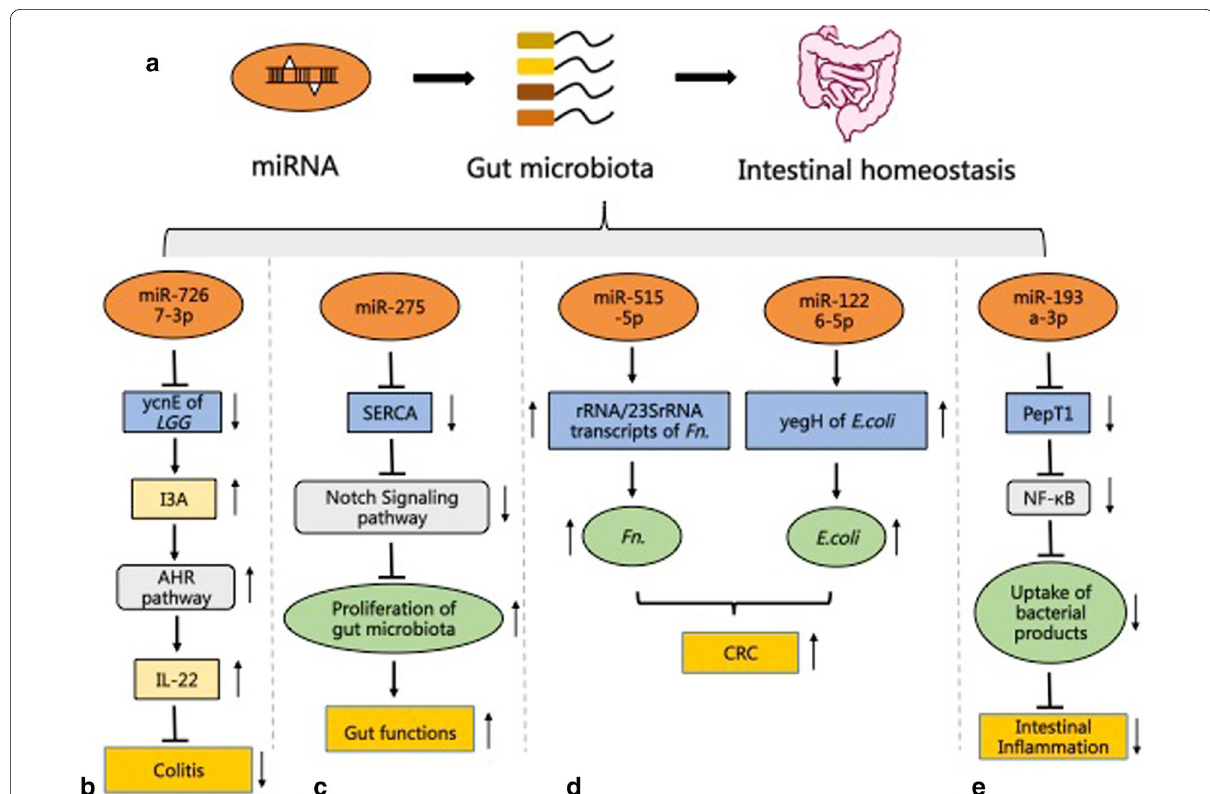
Fig. 1 MiRNAs regulate the gut microbiota affecting intestinal homeostasis. a MiRNAs regulate the gut microbiota influencing the intestinal homeostasis of the host. b The mechanism of miR7267‑3p alleviating colitis by repressing ycnE expression of the gut microbiota. c MiR‑275 protects gut functions in mosquitoes by shaping the gut microbiota. d MiRNAs promote the growth of the gut microbiota through the promotion of transcription, affecting the host CRC. e MiRNA‑193a‑3p reduces intestinal inflammation by decreasing the uptake of bacterial products. YcnE, monooxygenase ycnE; LGG, Lactobacillus rhamnosus ; I3A, indole‑3‑carboxaldehyde; AHR, aryl hydrocarbon receptor; IL‑22, interleukin 22; SERCA, sarco/endoplasmic reticulum Ca 2 + adenosine triphosphatase; Fn. , Fusobacterium nucleatum ; E. coli., Escherichia coli ; CRC, colorectal cancer; PepT1, peptide transporter family 1; NF‑κB, nuclear factor kappa‑B; Pathway diagram key: ┴ inhibition; The figure is referring to the known mechanisms in animal